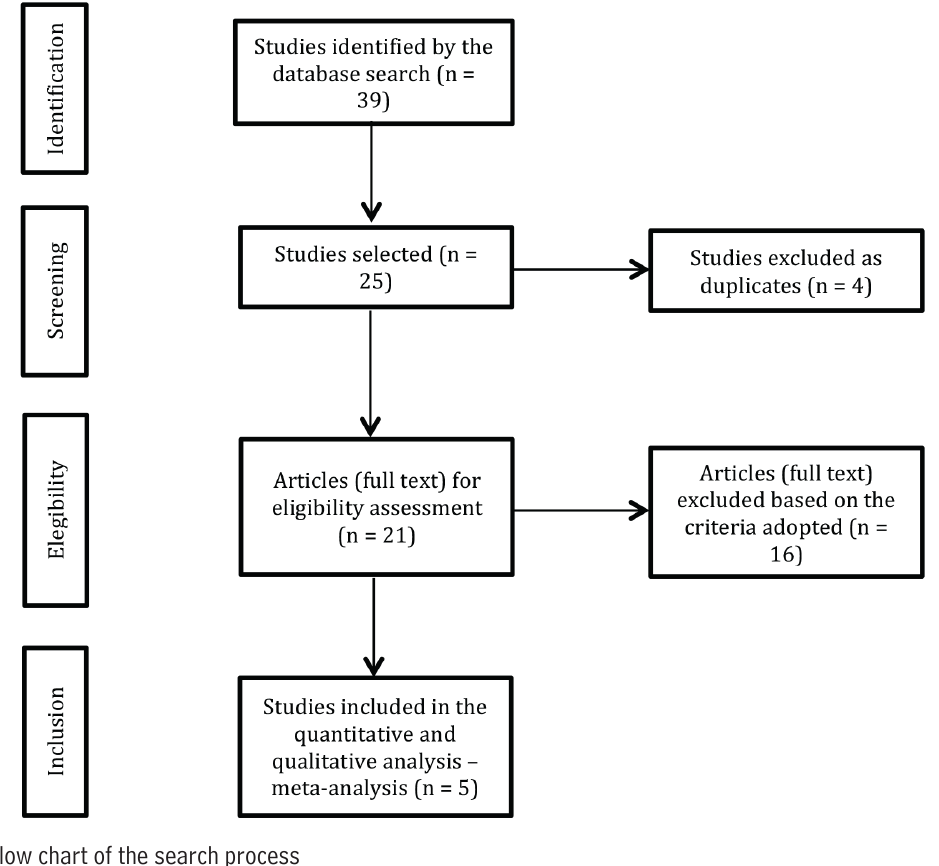
Figure 1 - Flow chart of the search process